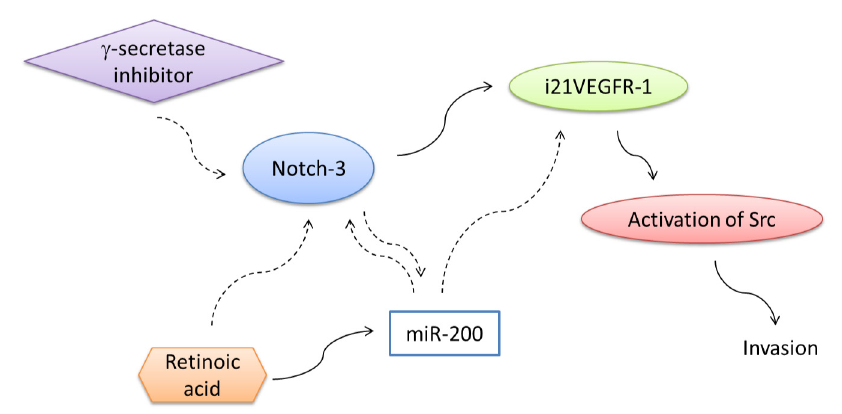
Figure 6. Expression of i21VEGFR-1 is positively regulated by the Notch pathway and negatively regulated by the micro RNA family miR-200. Addition of retinoic acid to the culture medium of MDA-MB-231 breast cancer cells inhibits the expression of the protein i21VEGFR-1. The effect of retinoic acid on the expression of the intracellular truncated isoform of VEGFR-1 is mediated by downregulation of Notch-3 expression. Moreover, retinoic acid increases the expression of the miR-200 family of micro RNAs in MDA-MB-231 breast cancer cells. The expression of the truncated intracellular protein i21VEGFR-1 decreases when the Notch signaling pathway is interfered with γ -secretase